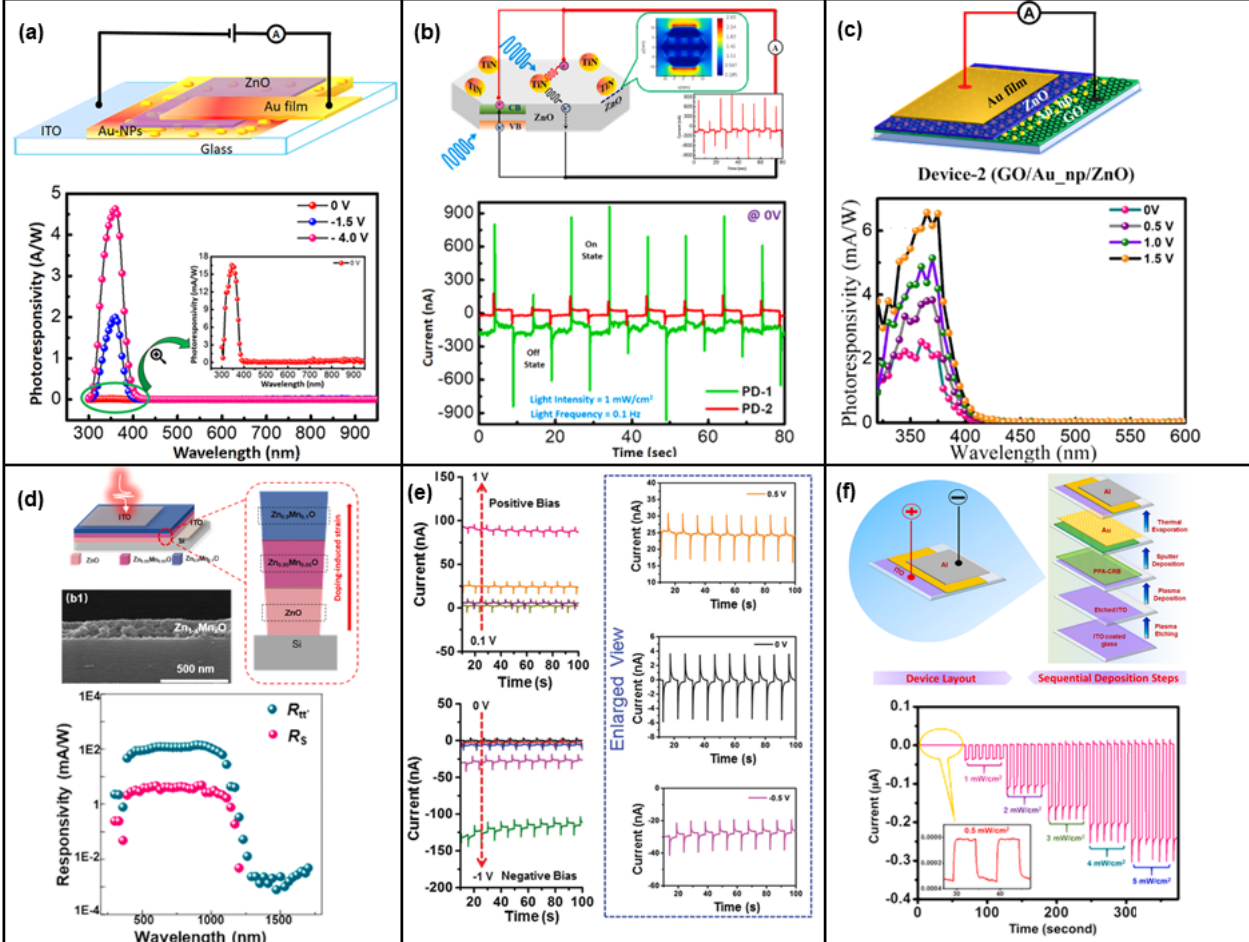
Figure 9. ( a ) The layout and photoresponsivity of the fabricated photodetector having configuration ITO/Au-NPs/ZnO/Au film. Reproduced with permission from [71]. Copyright 2021 Elsevier; ( b ) Structure diagram and comparative I–t response of the device under the illumination of 365 nm light along with the pristine one, which clearly depicts the prominent enhancement in the device performance after the incorporation of TiN nanoparticles in it. Reproduced with permission from